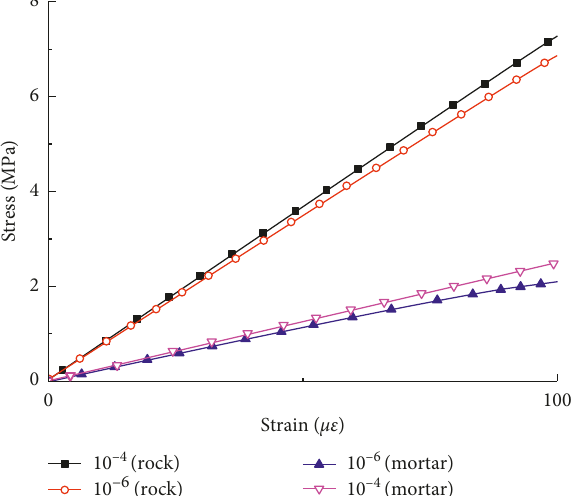
Figure 2: Stress-strain curve of rock-mortar interface under different strain rates.